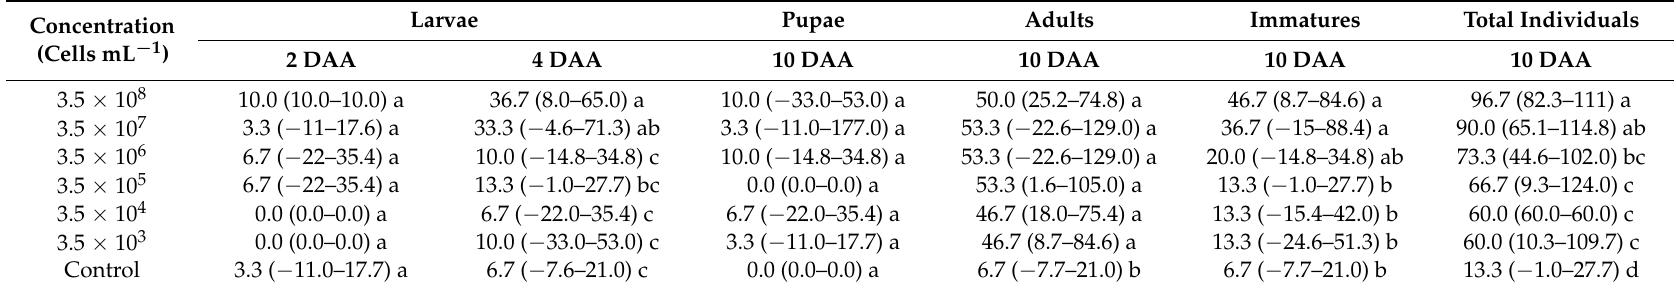
Table 1. Mortality of Drosophila suzukii larvae, pupae and adults following the Photorhabdus luminescens larval-oral bioassay.